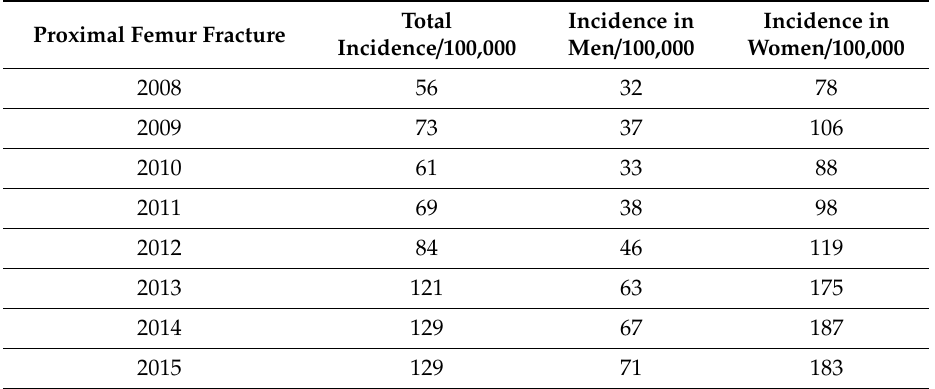
Table 2. Polish incidence rate of proximal femur (“hip”) fracture per 100,000 population by the year, standardized to the European